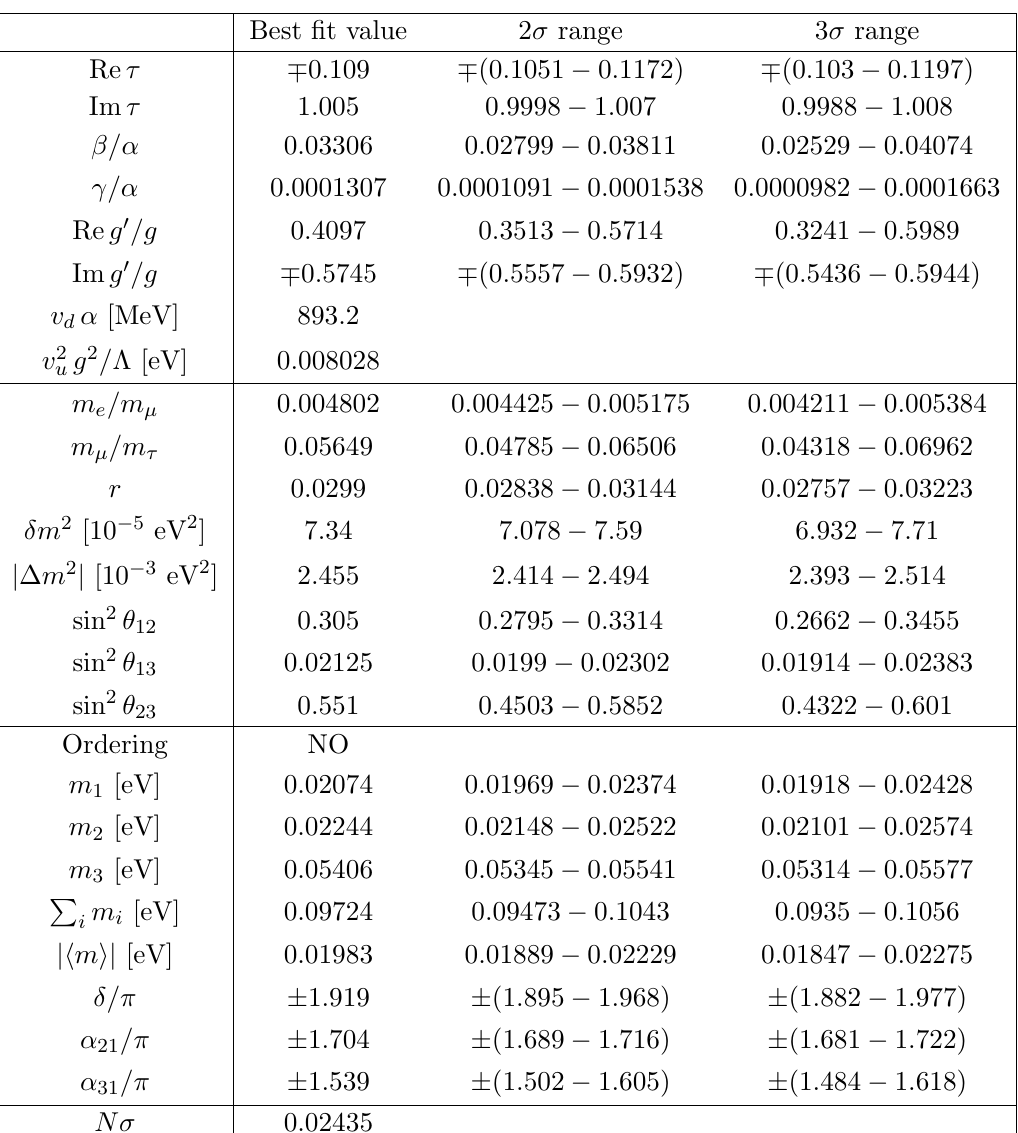
Table 5b. Best (cid:12)t values along with 2 (cid:27) and 3 (cid:27) ranges of the parameters and observables in cases B and B (cid:3) , which refer to ( k (cid:3) ; k g ) = (0 ; 2) and to a certain region in the (cid:28) plane (see (cid:12)gure